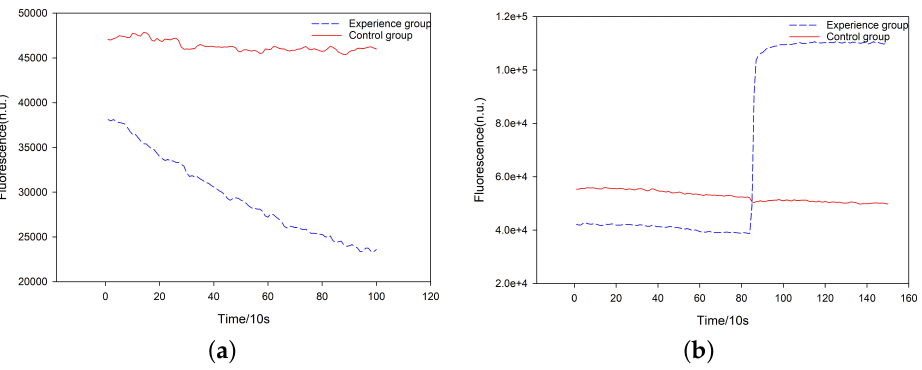
Figure 5. Biological experiment results. ( a ) The evolution of the concentration of Species A in the DR- module. ( b ) The evolution of the concentration of A in the CR-module. The concentration change of Species A in the experiment is the same as that in the